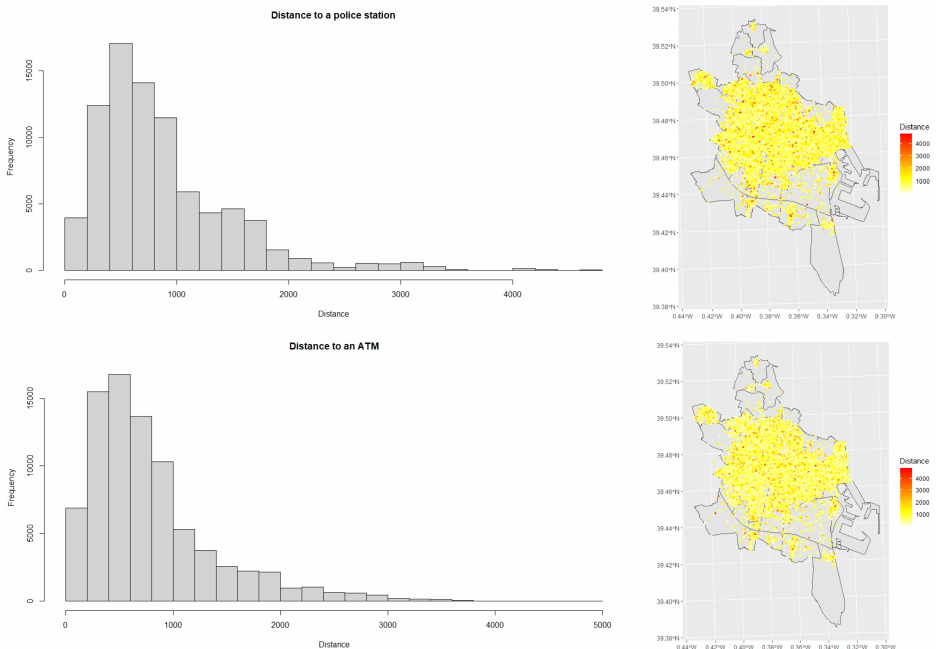
Figure 9. Histogram and corresponding point patterns coloured by their minimum distances to police stations (top row) and to ATMs (bottom